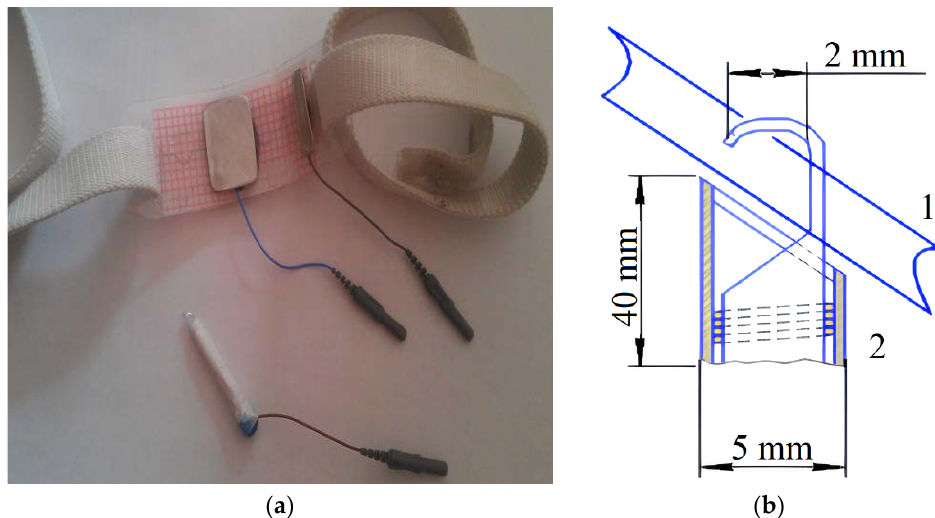
Figure 4. This designed electrode system: ( a ) the overview of the attached electrode with the clamp and ( b ) the clamp setup. 1—needle, 2—clamp.